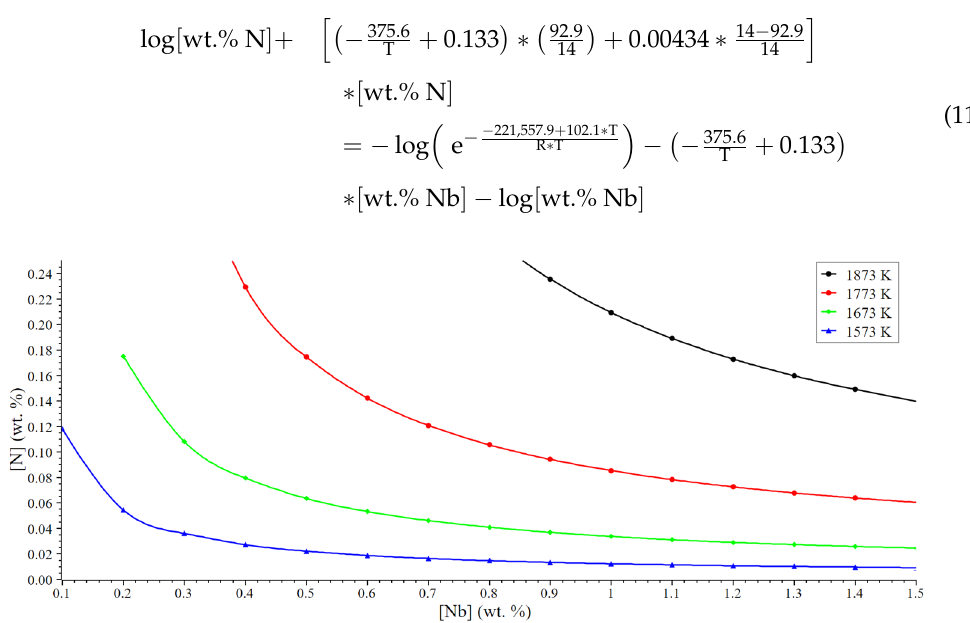
Figure 2. Temperature dependence of the equilibrium solubility product of niobium and nitrogen in liquid steel melt.